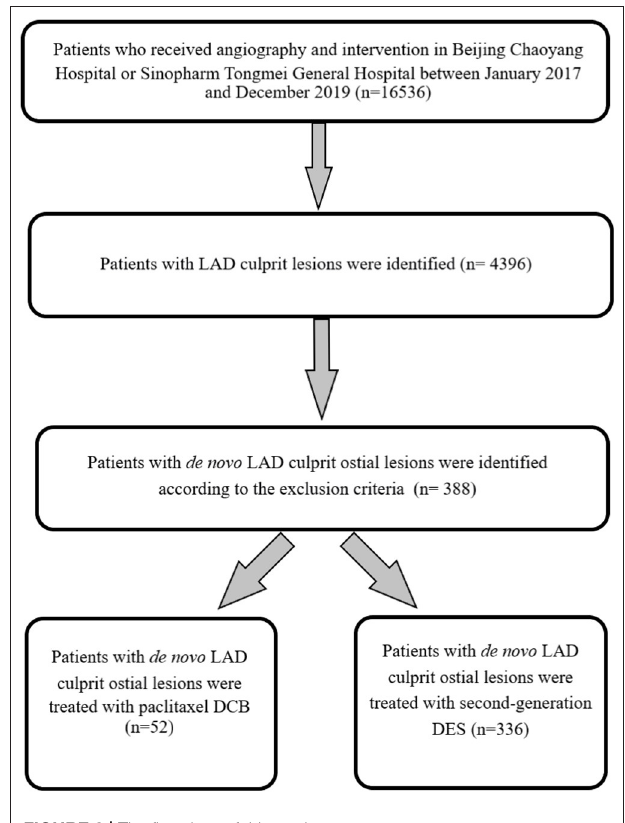
FIGURE 2 | The flowchart of this